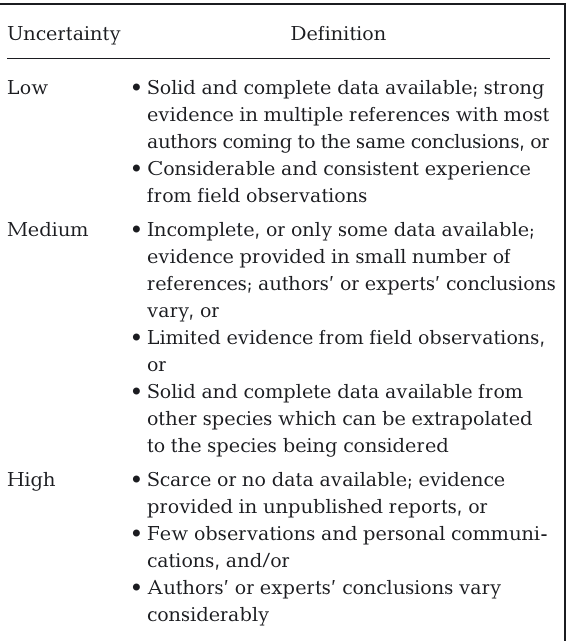
Table 2. Definitions of levels of uncertainty used in risk assessment (EFSA